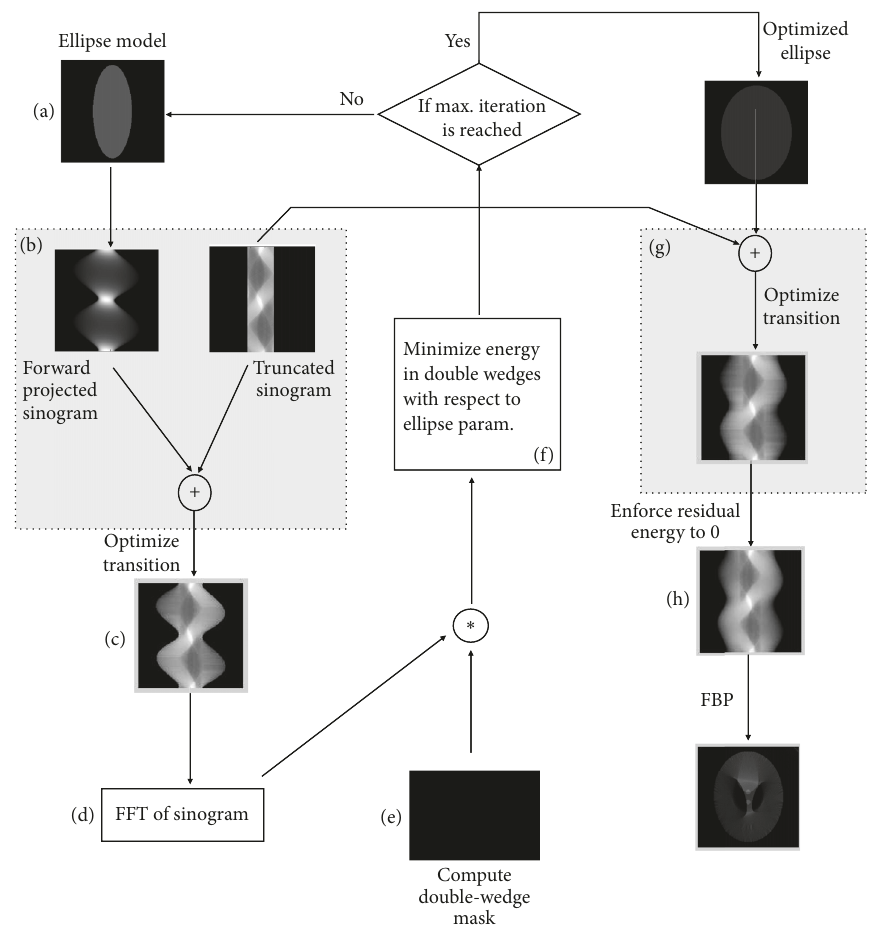
Figure 2: Flowchart of the proposed sinogram completion scheme: Set up an ellipse model for sinogram completion and optimize the model parameters (here the two ellipse radii) by enforcing the Fourier